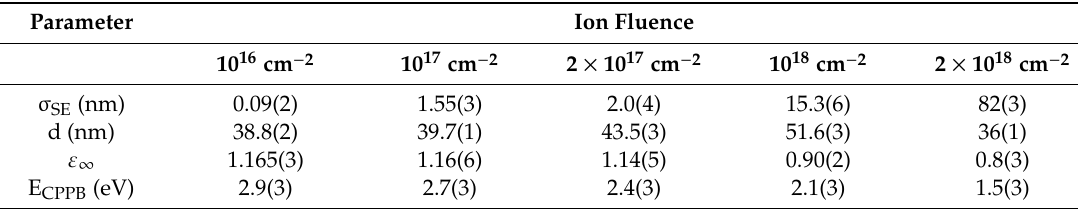
Table 1. Parameters obtained from the best fits of the SE model: roughness ( σ ), thicknesses of the damaged layer (d), high-frequency limit dielectric constant ( ε ∞ ), and energy of the critical point (E CPPB ). Errors in the last digit are indicated in parenthesis and correspond to the 90% confidence limits.